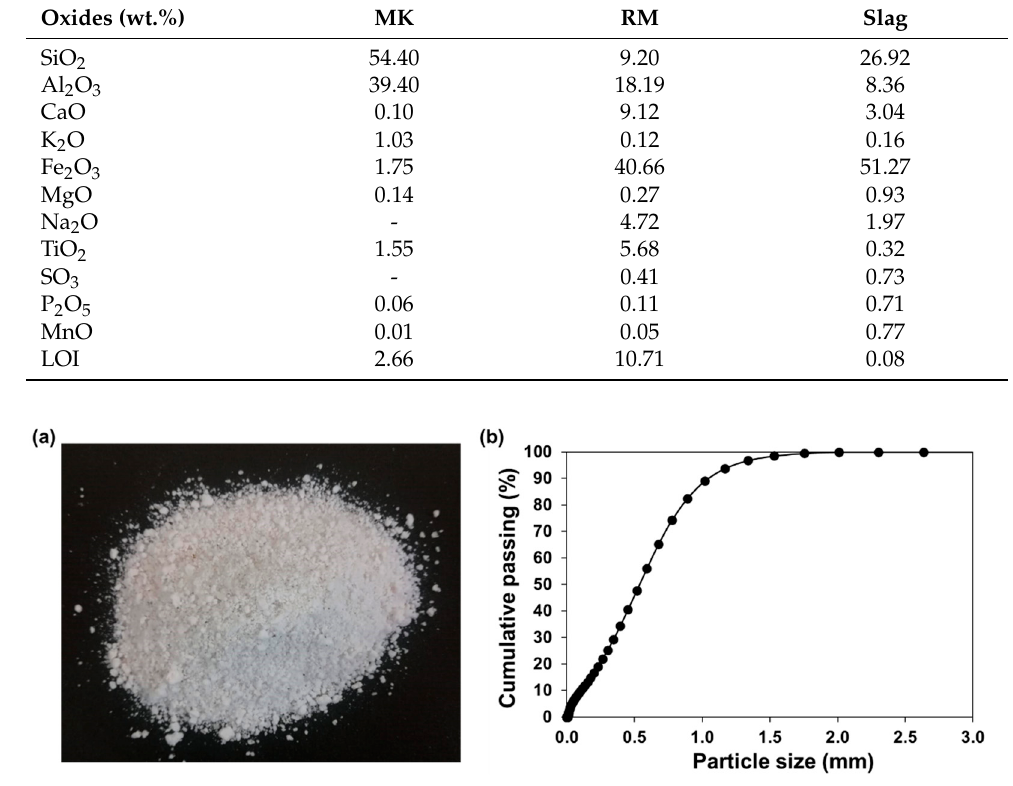
Figure 1. ( a ) Expanded perlite aggregate and its ( b ) particle size distribution.